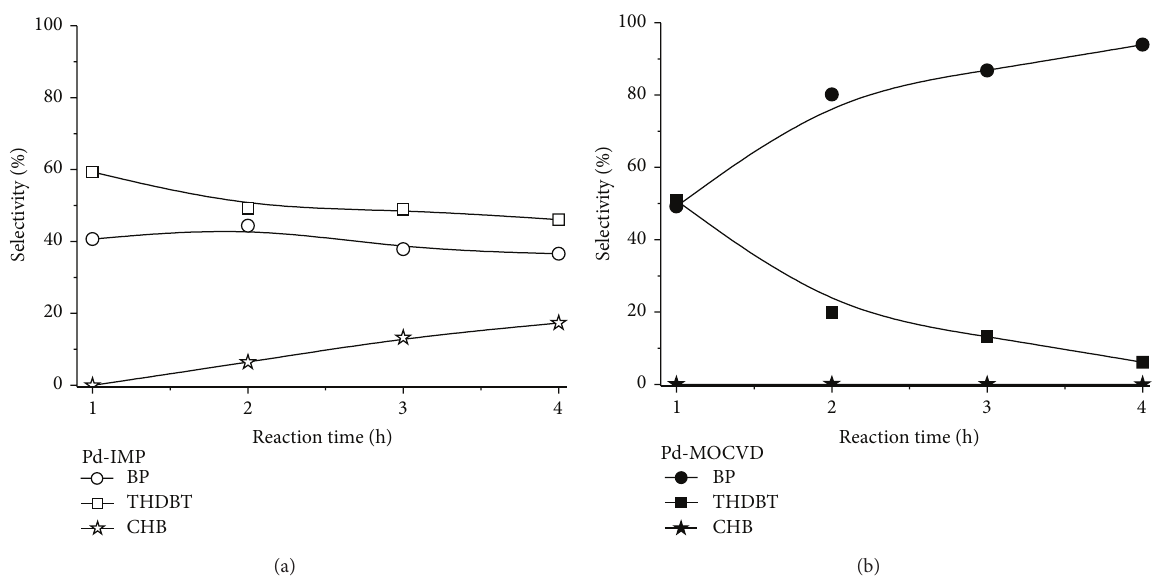
Figure 6: Profiles of HDS selectivity in the HDS of DBT reaction over monometallic Pd catalysts prepared by (a) IMP and (b) MOCVD method.